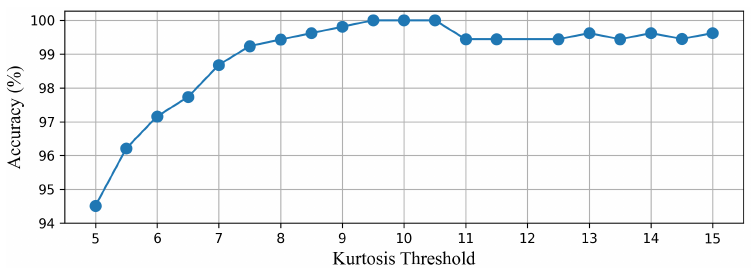
Figure 10. Impact of the kurtosis threshold on the accuracy of the